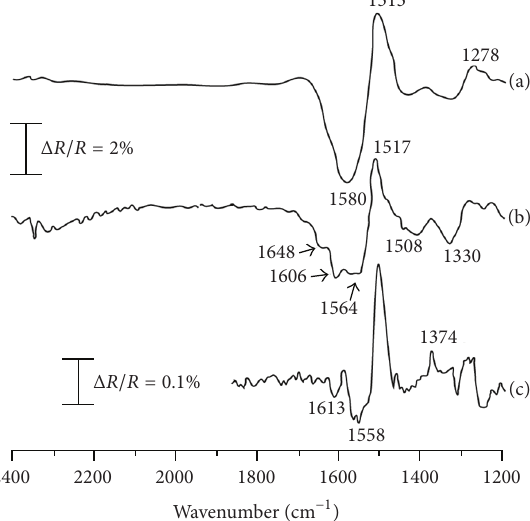
F 7: FTIR spectra for a Pt electrode covered with POAP in solution in (a) water and (b) deuterated water. Sample